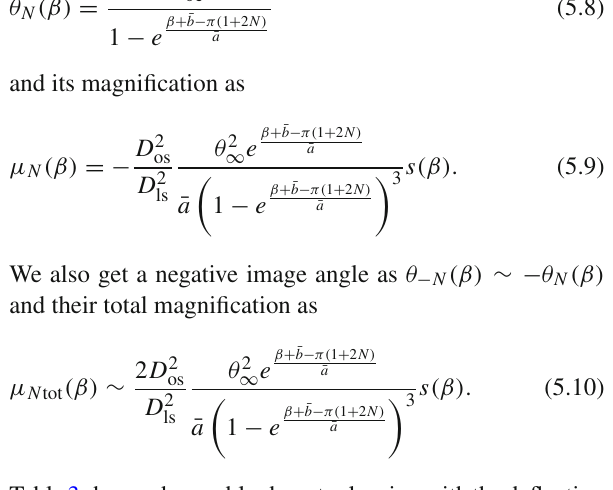
Table3showsobservablesbyretrolensingwiththedeflection angle